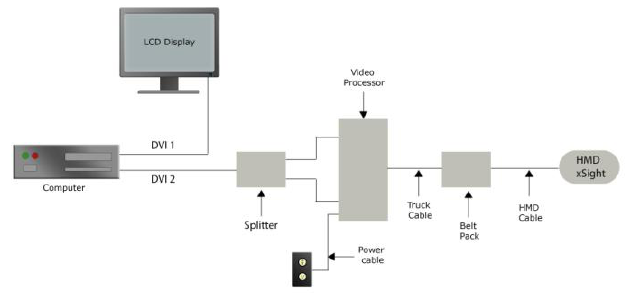
Fig. 9. Graphical output of the system for a Sensics xSight 3120 HMD. Adapted from